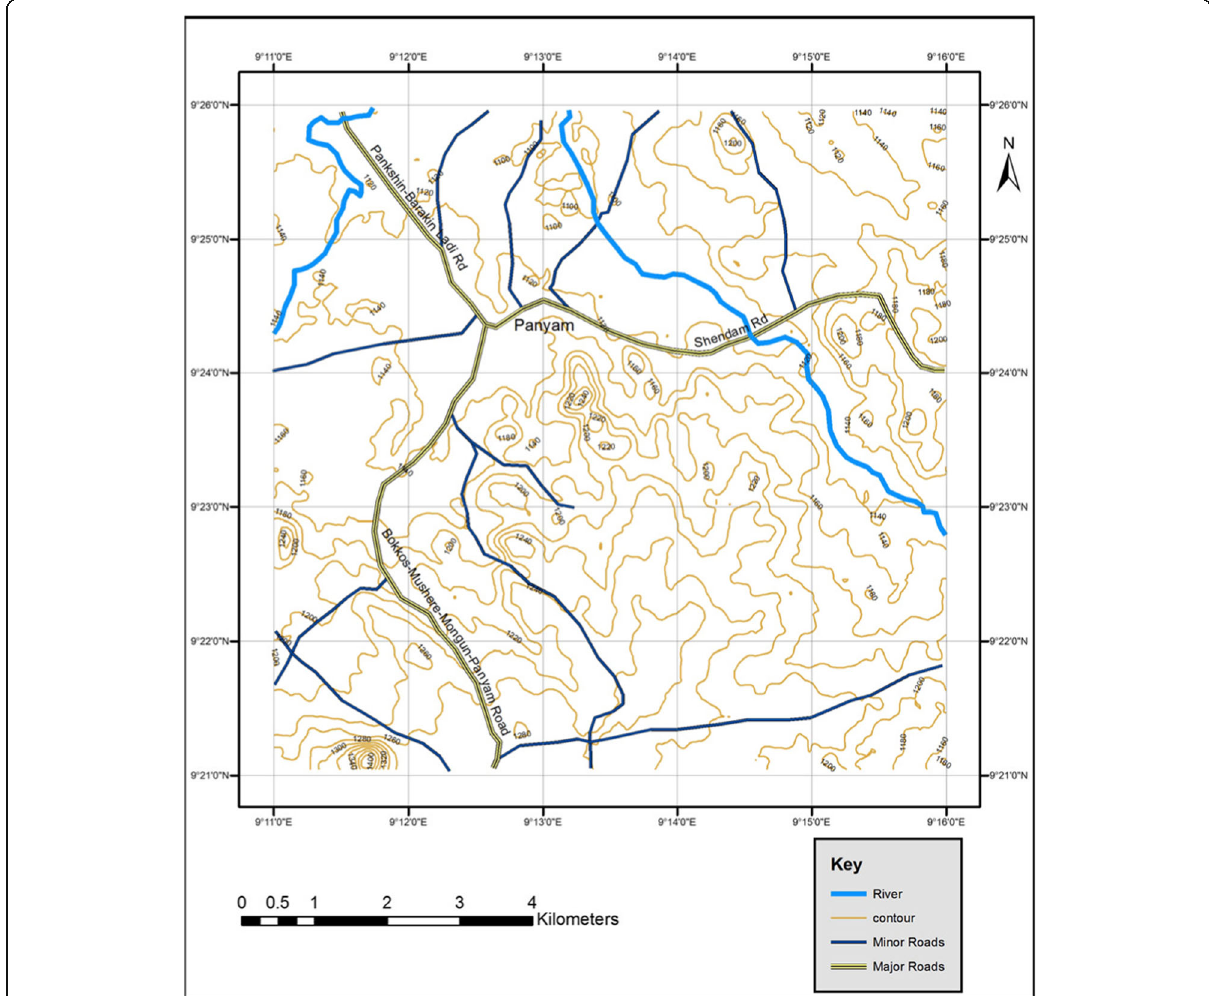
Fig. 2 Topographic Map of the Study